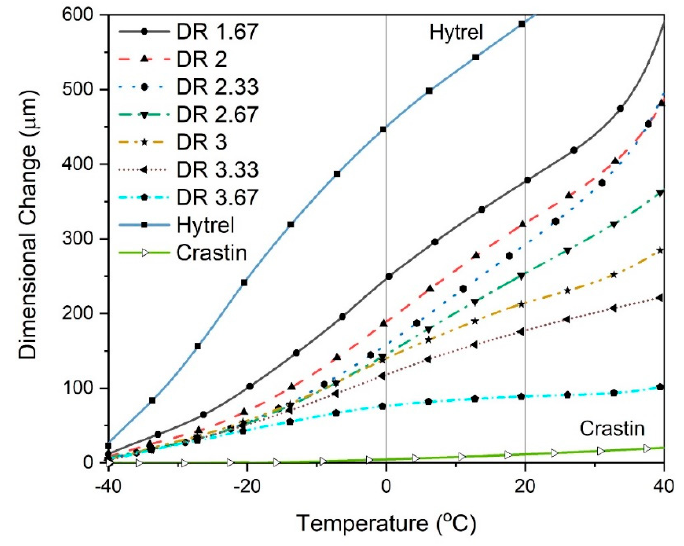
Figure 6. TMA curves for Monocomponent fibers (labelled Hytrel and Crastin) and Bicomponent fibers with respective draw ratios (DR).